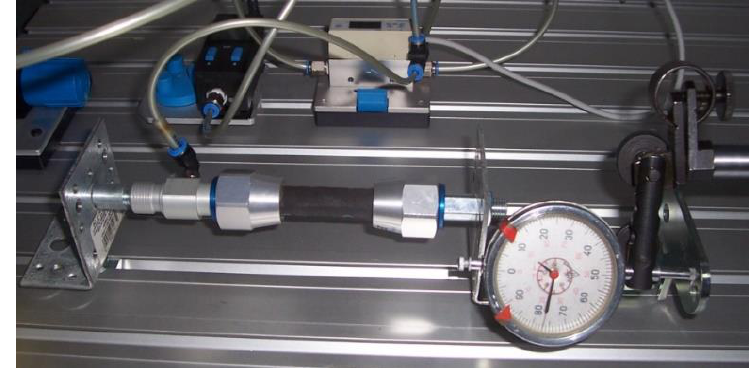
Figure 7. Experimental set-up for determining the hysteresis of muscle axial displacement.